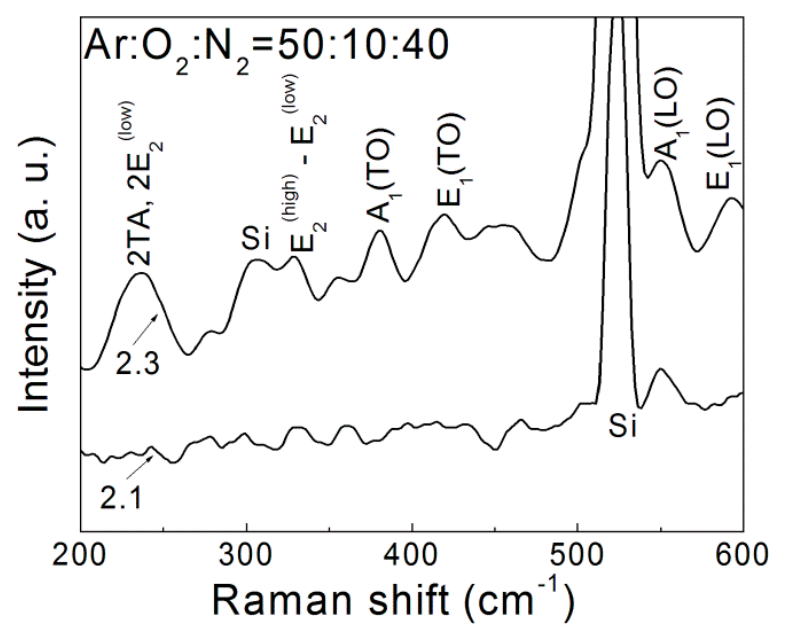
Figure 1. Representative Raman spectra of ZnO:N films, deposited in a gas mixture of Ar:O 2 :N 2 = 50:10:40 (sample 2.1) and after RTA at 550 °C (sample 2.3). Table 2. Position of the Raman phonon modes in the ZnO:N thin